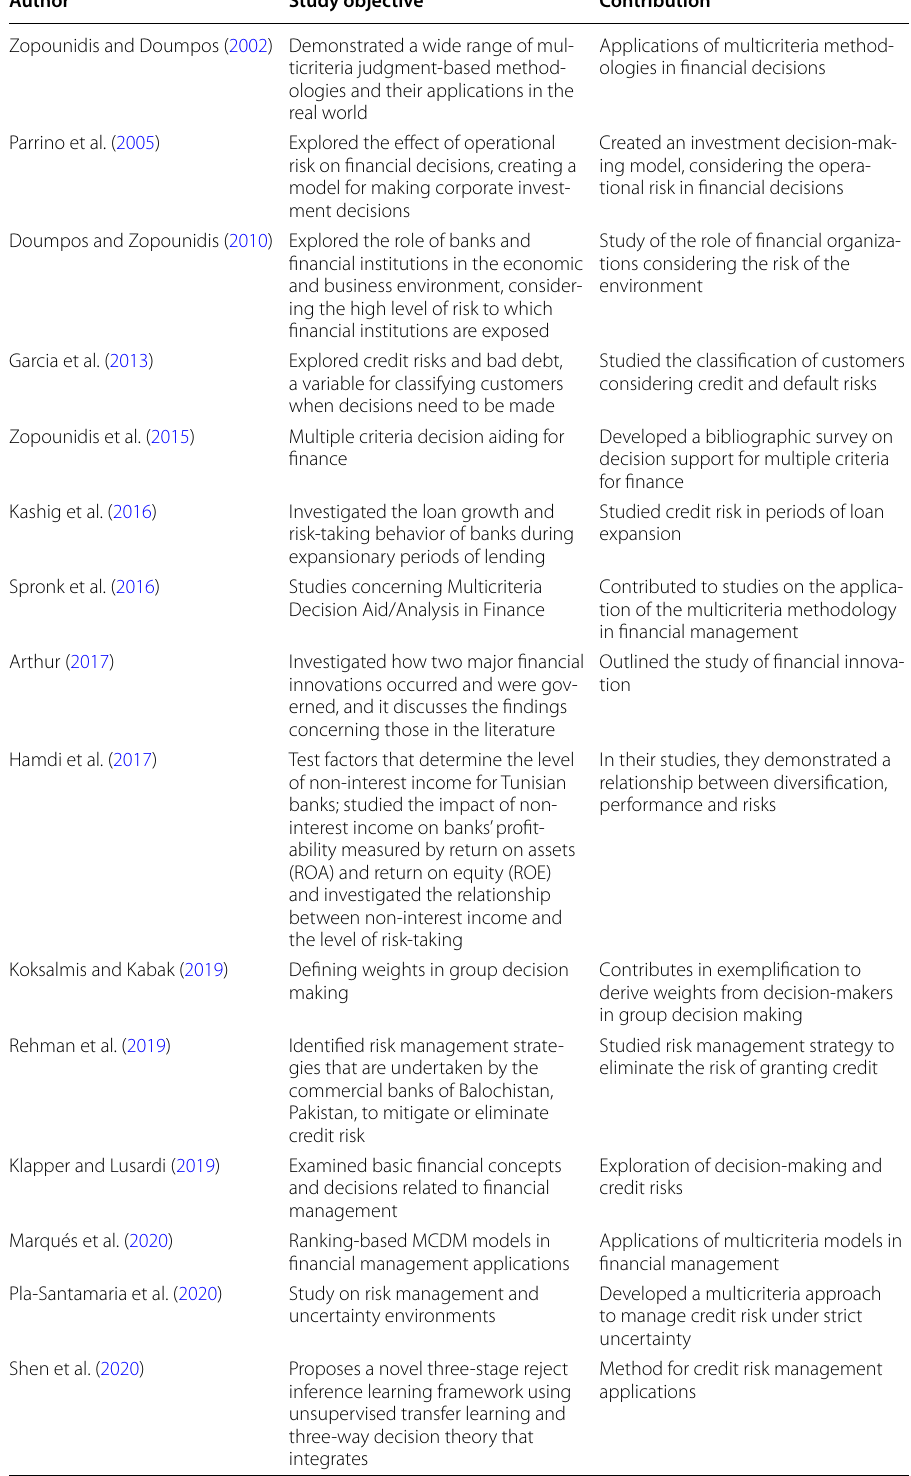
Table 2 Summary of studies on the credit-granting environment, the risks involved, and financial